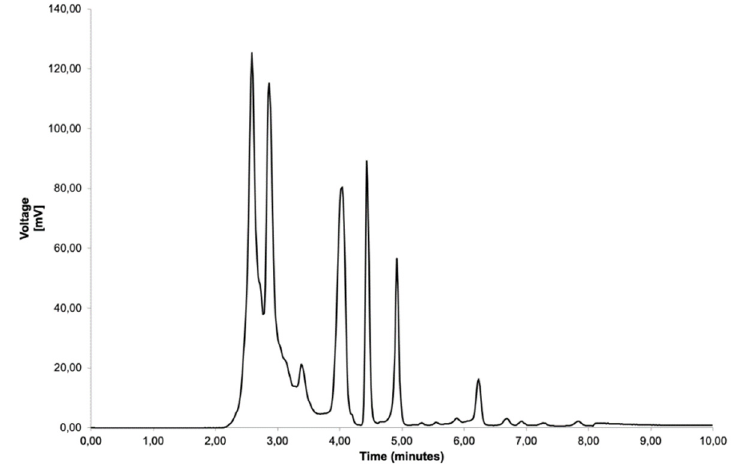
Figure 5. Chromatogram obtained with a solution containing 200 µ g/mL of both PDX and TZD after exposure to direct sunlight for a period of 24 h. Table 6. Percentage purity (%) calculated for PDX and TZD during exposure to various storage conditions as well as harsh environments for a period of three days.